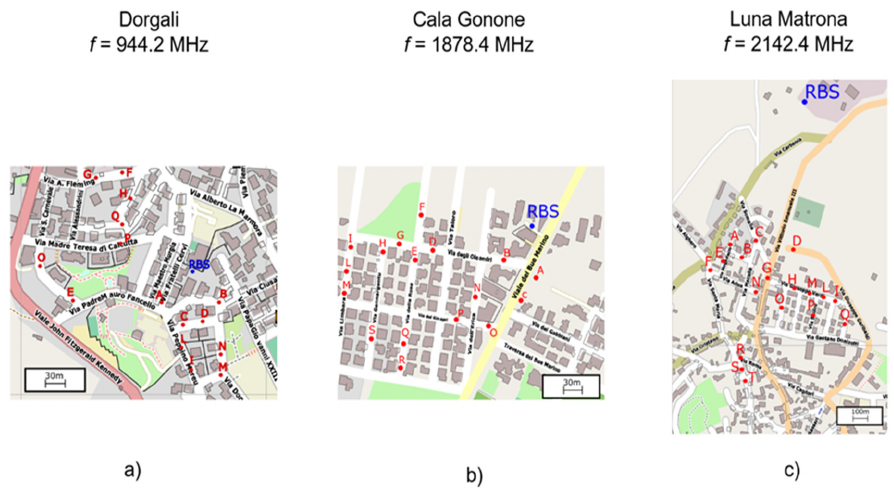
Figure 6. Topology of the three sites for the measurement campaigns. ( a ) Dorgali (NU, Italy): the working frequency of the RBS is 944.2 MHz, for a Kathrein 730376 antenna located 20 m above the road level. Fifteen measurement points were selected (A–Q). ( b ) Cala Gonone (NU, Italy): the working frequency of the RBS is 1878.4 MHz, for a Kathrein 742212 antenna located 10 m above the road level. Seventeen measurement points were selected (A–S). ( c ) Lunamatrona (CA, Italy): the working frequency of the RBS is 2142.4 MHz, for a Kathrein 742212 antenna located 30 m above the road level. Eighteen measurement points were selected (A–T).